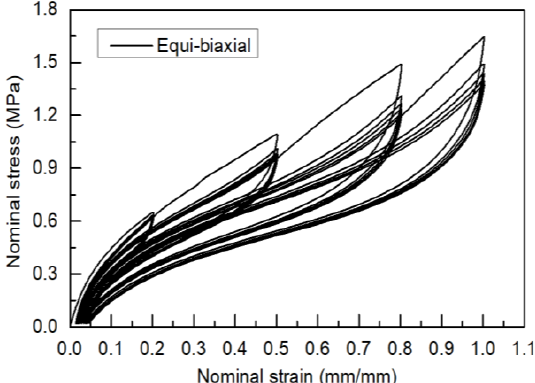
Figure 2. Stress – strain curves of the natural rubber under equi-biaxial tension.